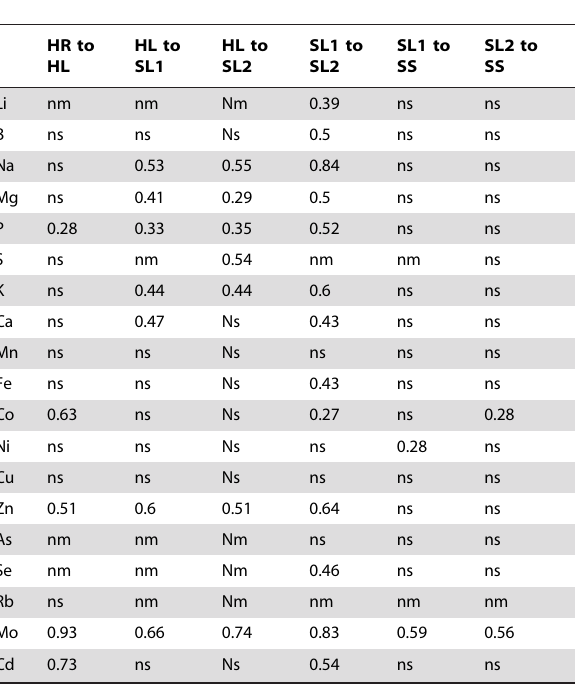
Table 4. Significant (p , 0.001) Correlations between Tissues for each